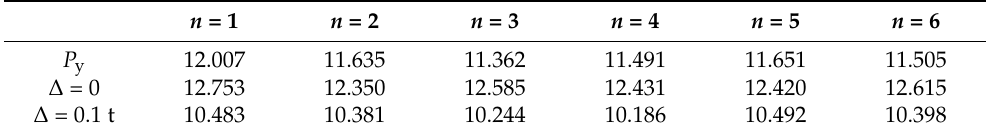
Table 6. First yield load ( P y ) and nonlinear buckling load ( ∆ = 0 and 0.1 t ) for sphere-segmented toroidal shells with a segment number ( n ) of